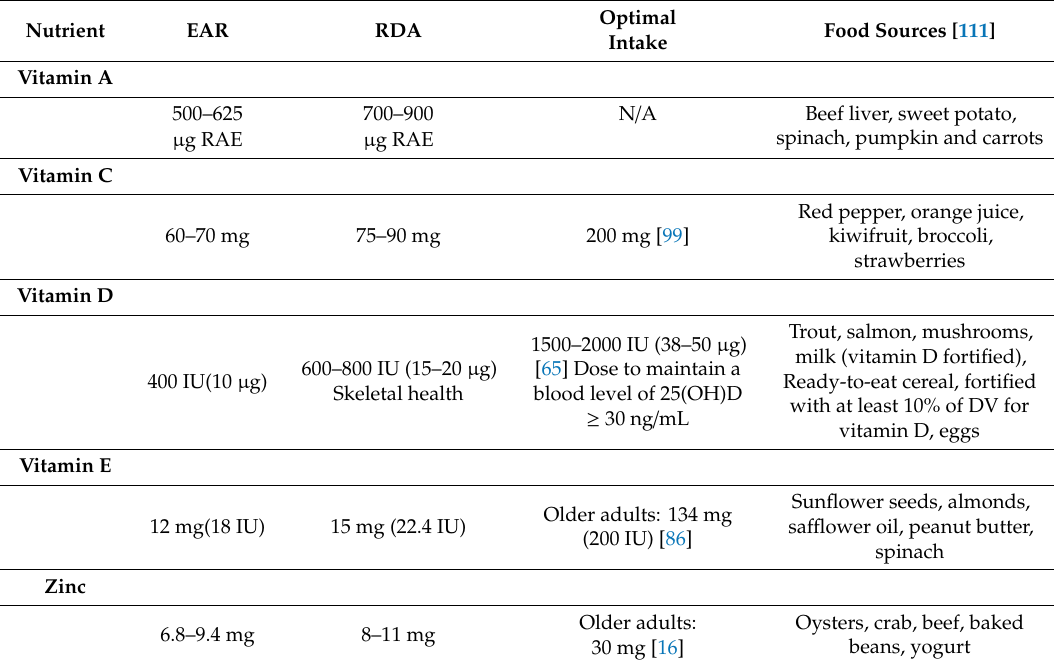
Table 1. Nutrient Daily Recommendations and Food